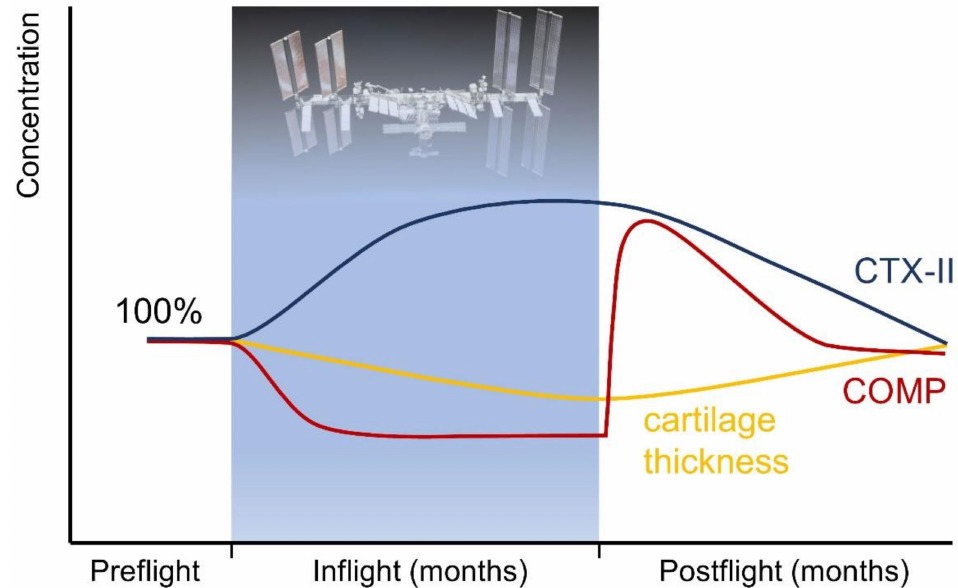
Figure 1. Estimated trajectories of human COMP serum and CTX-II urine concentrations, as well as of cartilage thickness during and after spaceflight based on the findings summarized in this review. COMP and CTX-II might be candidates to monitor the efficacy of in-flight countermeasures to prevent cartilage